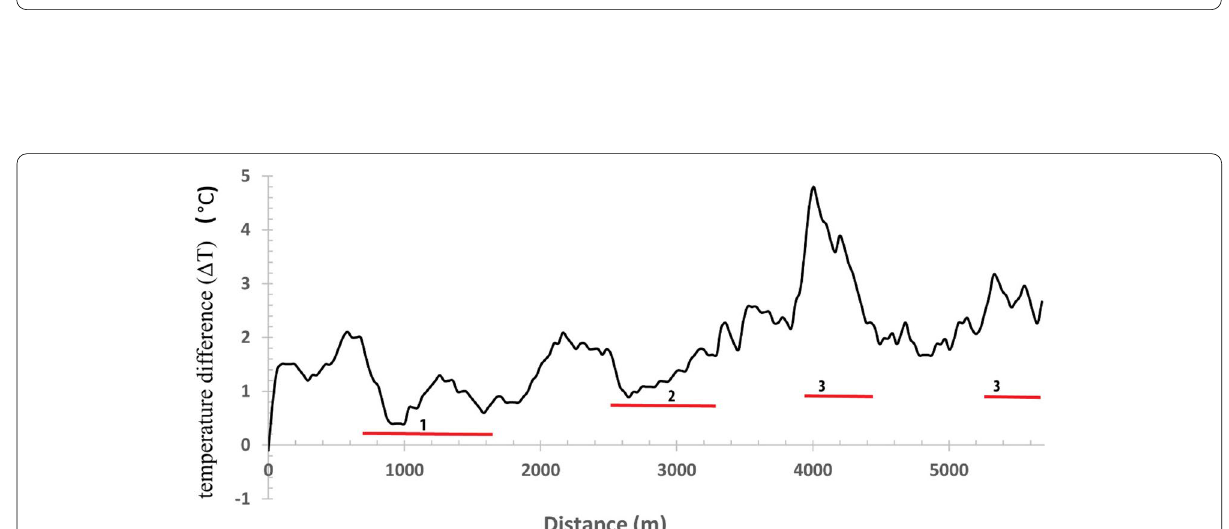
Fig. 11 Temperature differences between fixed and mobile sensor (ΔT) for the late afternoon traverse undertaken on 5 th January 2018. The various land cover types encountered are represented in red lines numbered 1 – 3. The corresponding description the landscape features are shown